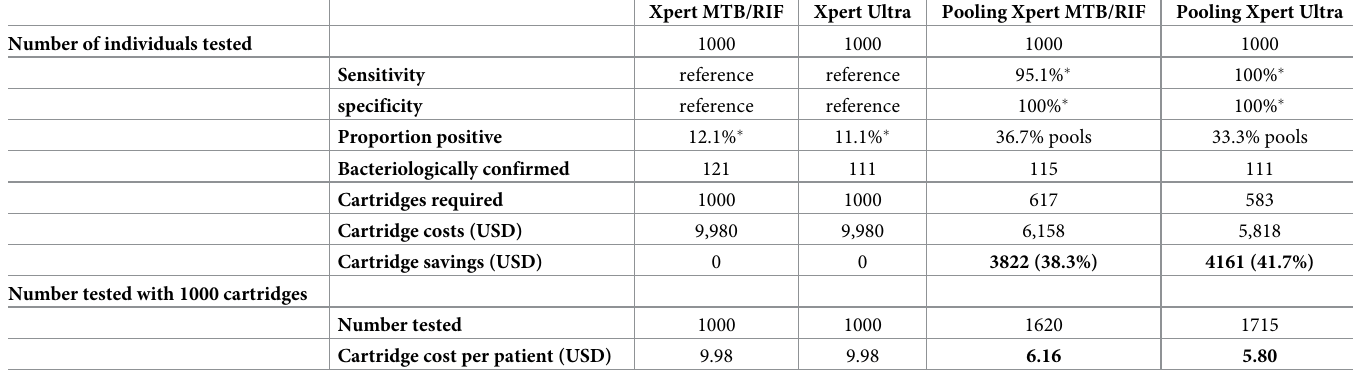
Table 4. Cost and diagnostic savings to screen 1000 consecutive patients using the pooling method and number of patients that could be tested with 1000 Xpert MTB/RIF and Xpert Ultra cartridges.